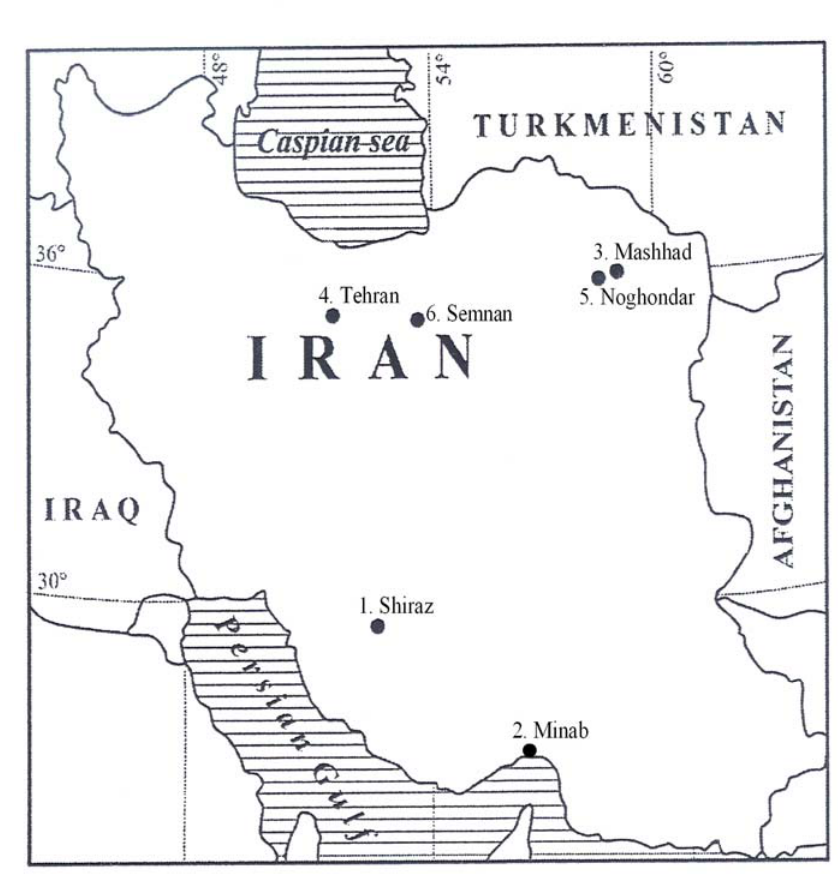
F IGURE 1. Sampling localities Map in this study. R. rattus (1, 2), R. norvegicus (3, 4), R. pyctoris (5), R. sp.